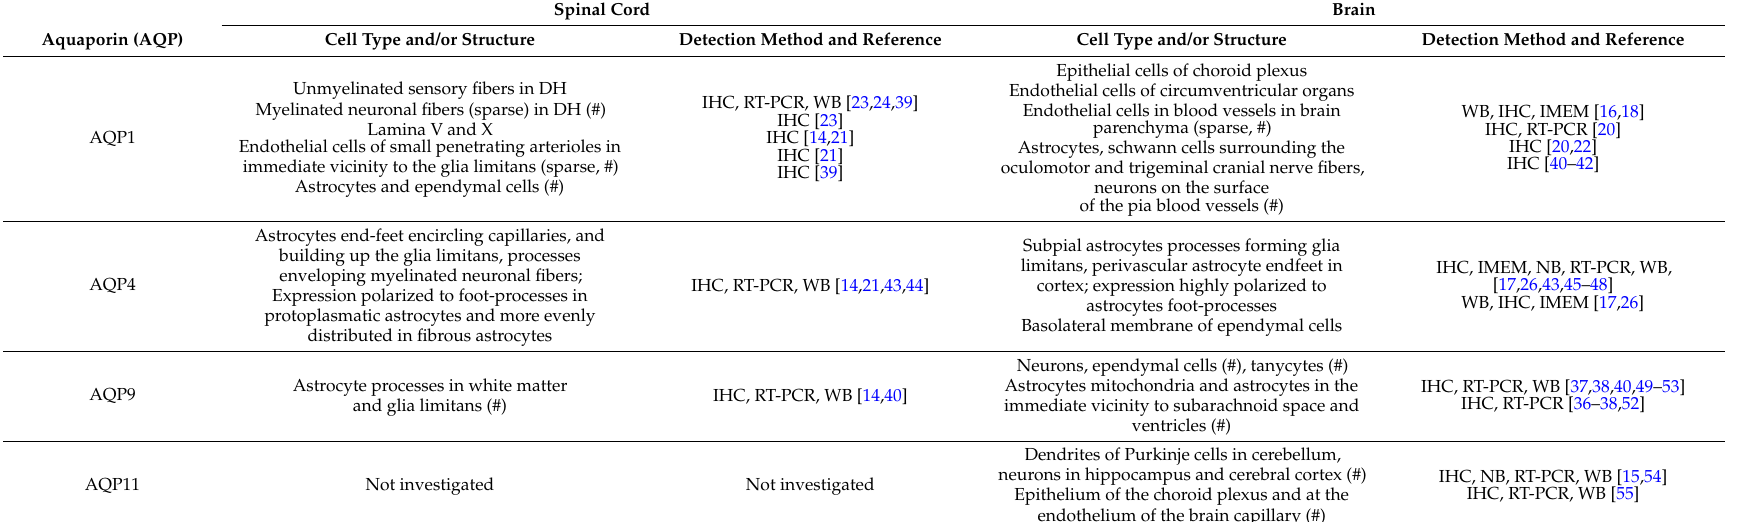
Table 1. Comparison of AQP1, AQP4, AQP9 and AQP11 expression between spinal cord and brain cells and